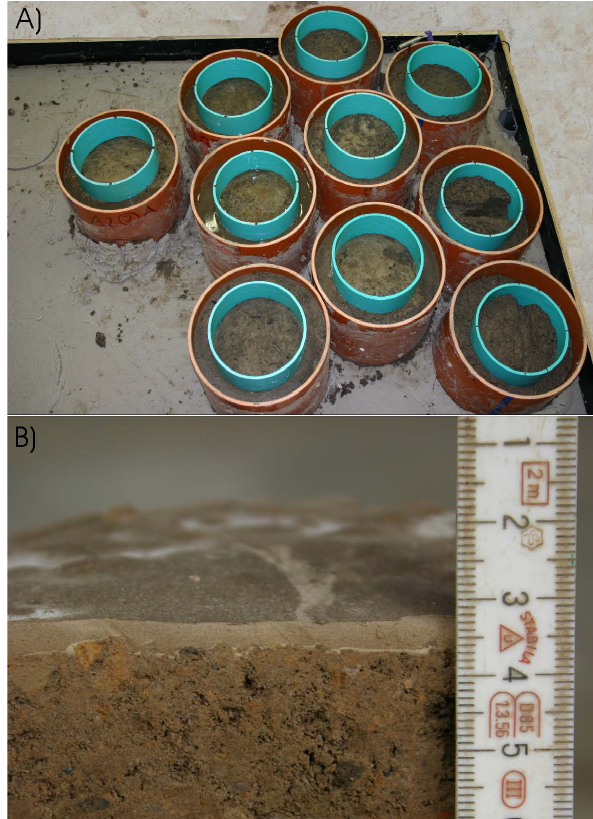
Fig. 2. (A) Sand box with undisturbed soil cores from deposition zones. (B) Cross-section of soil core, sampled after the mixture runs with a 0.5cm deposition layer clearly visible on top of the original soil